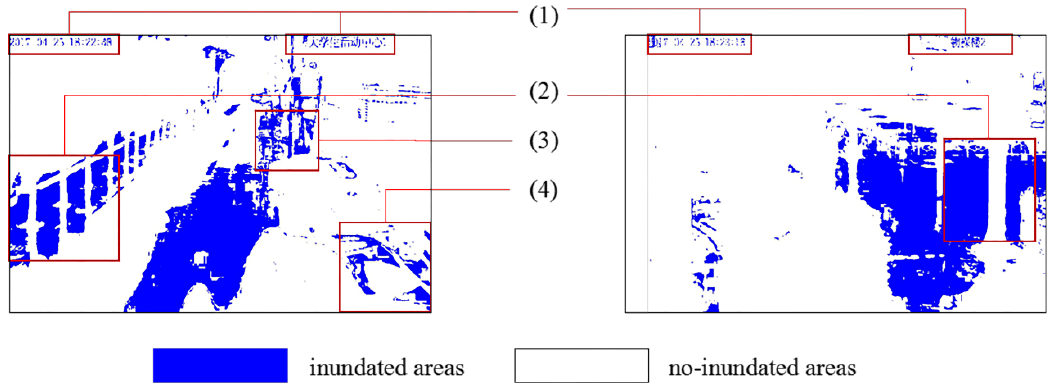
Figure 14. The results of supervised classification.